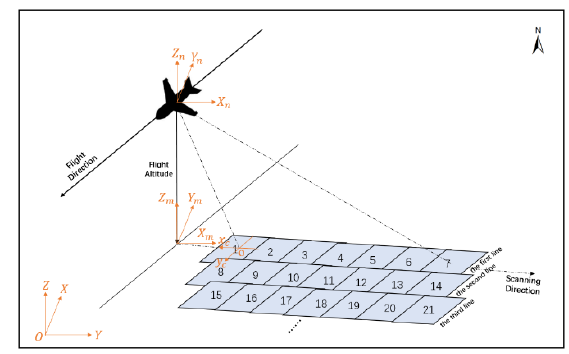
Figure 1 . Schematic diagram of camera imaging. In the process of small view field whiskbroom imaging, each small area array satisfies a collinearity equation and the movement of the electro-optic aiming line (scanning mirror) can Table 1. Comparison of performance parameters of several be described as rotation between coordinate systems. Therefore, typical aerial cameras for each small area array, the position of perspective centre obtained by GPS and the three angles of pitch, roll and yaw obtained by Inertial Measurement Unit (IMU) in POS system should be combined with the roll angle 𝜃 𝑅𝑂𝐿 and the pitch angle 𝜃 𝐸𝐿 of electro-optic aiming line, to obtain 6 external orientation elements (3 elements for position and 3 angles for attitude at the exposure time). These 6 external orientation elements are used to establish the strict mathematical relationship between the image point (𝑥, 𝑦, −𝑓) and the corresponding ground point (𝑋,𝑌, 𝑍) , which is the basis of object positioning calculation.